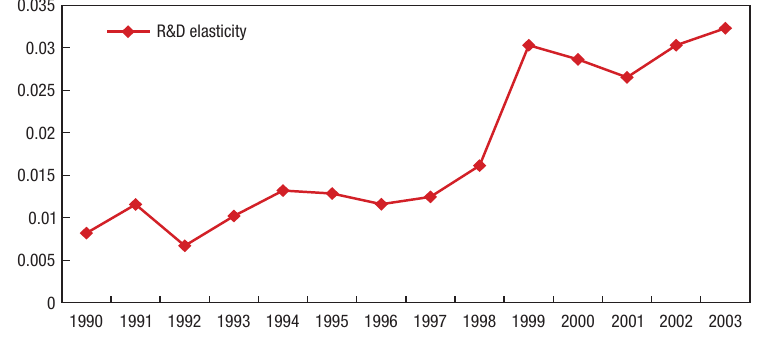
Fig. 4. Trend in elasticity of R&D productivity